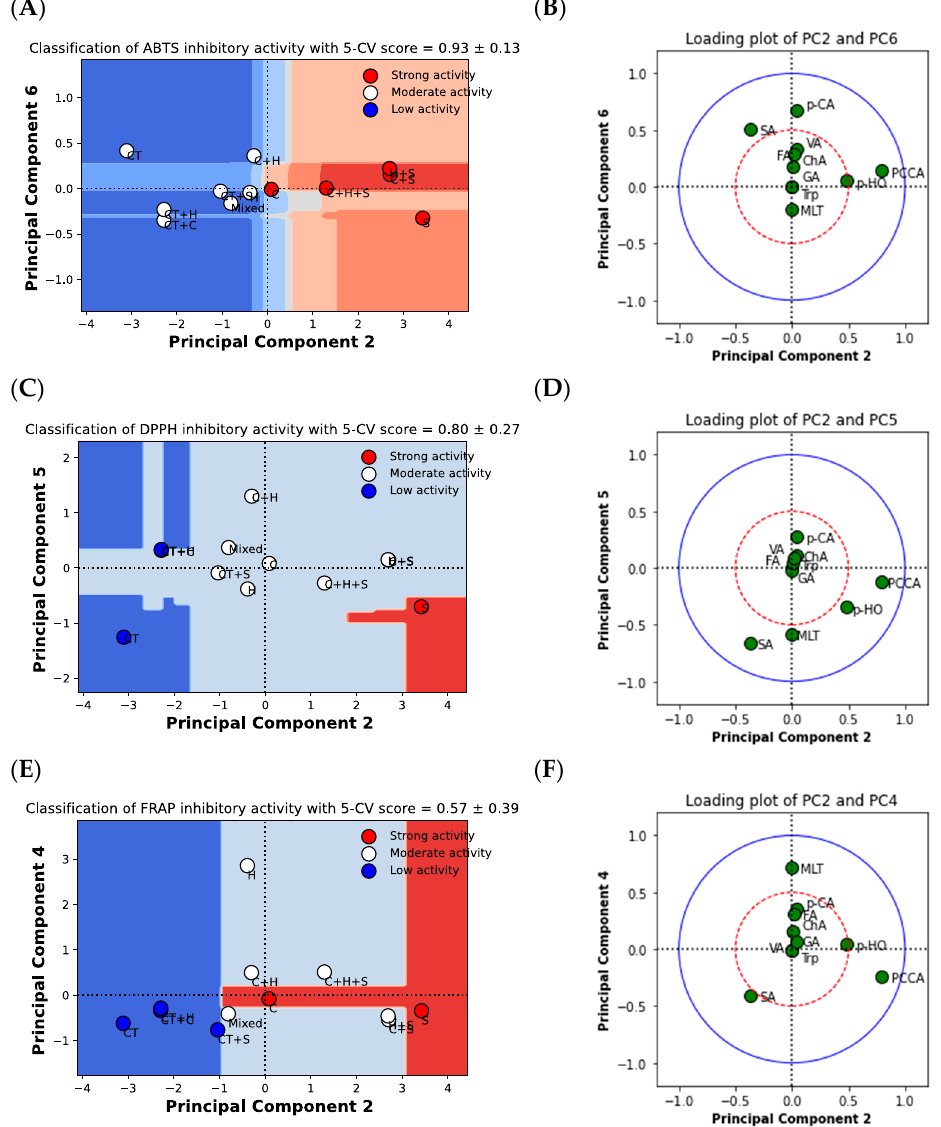
Figure 3. Principal component analysis, decision boundary and loading plots between the phyto- chemical components and antioxidant inhibitory activities of 12 samples. ( A ) Score plot with decision boundary between PC2 and PC6. The samples were classified based on the strong (red circle) and moderate (white circle) ABTS inhibitory activities. ( B ) Loading plot between PC2 and PC6. The red and blue lines determine the correlation of phytochemical components between PC2 and PC6 at 0.5 and 1.0, respectively. ( C ) Score plot with decision boundary between PC2 and PC5. The sam- ples were classified based on the strong (red circle), moderate (white circle), and low (blue circle) DPPH inhibitory activities. ( D ) Loading plot between PC2 and PC5. The red and blue lines deter- mine the correlation of phytochemical components between PC2 and PC5 at 0.5 and 1.0, respec- tively. ( E ) Score plot with decision boundary between PC2 and PC4. The samples were classified based on the strong (red circle), moderate (white circle), and low (blue circle) FRAP inhibitory ac- tivities. ( F ) Loading plot between PC2 and PC4. The red and blue lines determine the correlation of phytochemical components between PC2 and PC4 at 0.5 and 1.0, respectively. Figure 3C shows that the DPPH inhibitory activity was categorized into three classes, namely strong (i.e., S), moderate (i.e., C, H, CT + C, CT + S, C + H, C + S, H + S, C + H + S, and mixed) and low inhibitory activity (i.e., CT, and CT + H) by PC2 and PC5, with a five- fold CV accuracy score of 0.80 ± 0.27. Figure 3D shows that strong and moderate DPPH inhibitory activities were strongly correlated with protocatechuic acid and p -